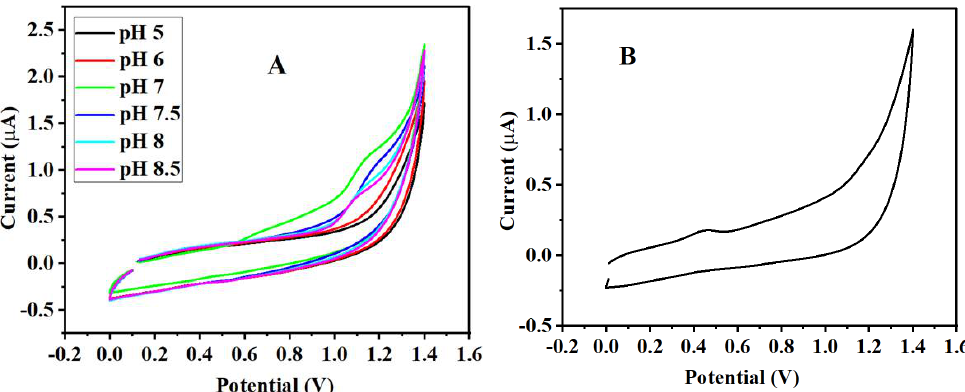
Figure 6. ( A ) CV in 0.1 M PBS at pH ranging from 5.0–8.5 containing 47.6 µM EFV and ( B ) in PBS only on at GCE/TiO 2 -NPs-nafion at 25 mV/s.